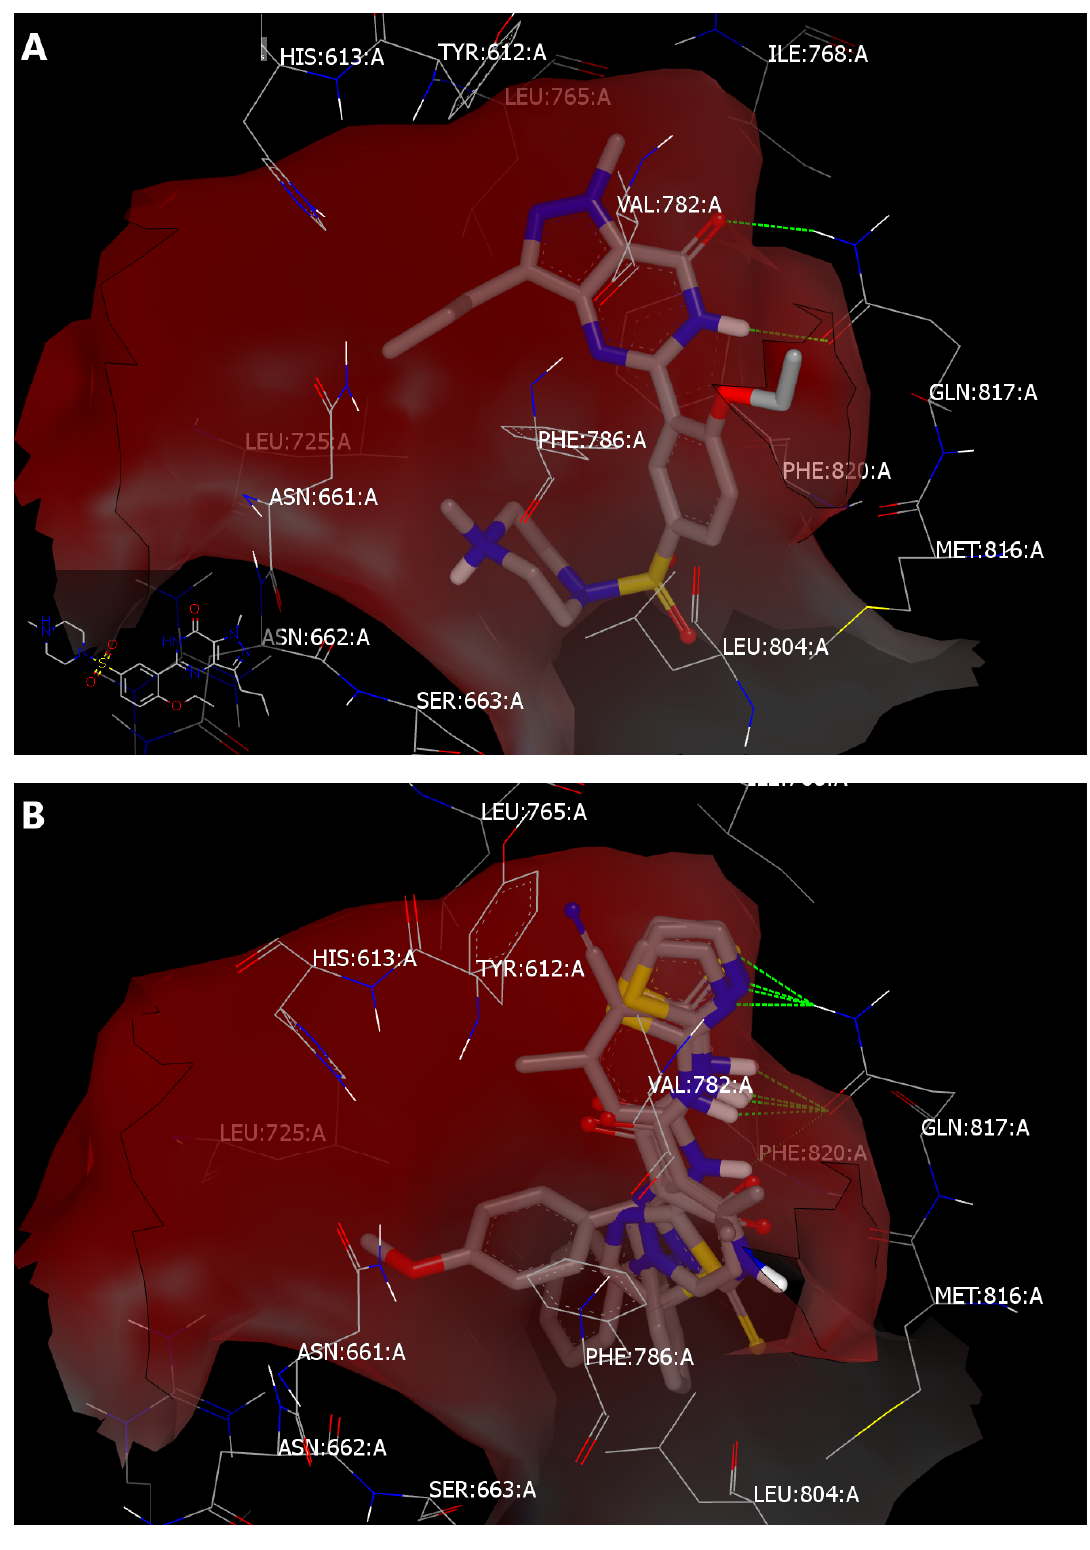
detailed docking results are reported in the Supplementary